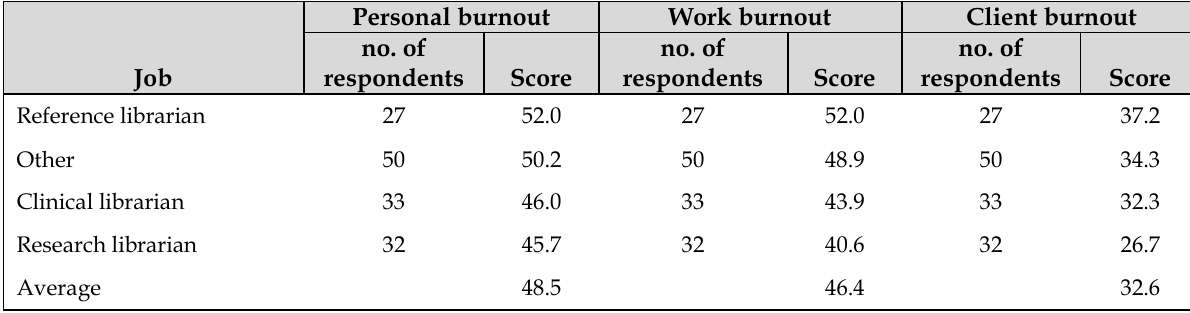
Table 2 Average CBI burnout scores by job